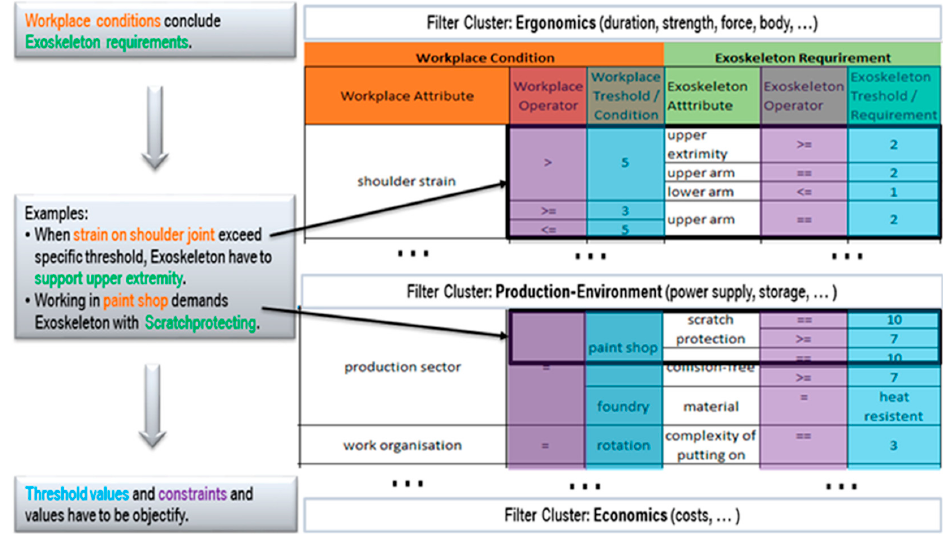
Figure 4. Database matching tables (DBMT): implement workplace-specific filter.